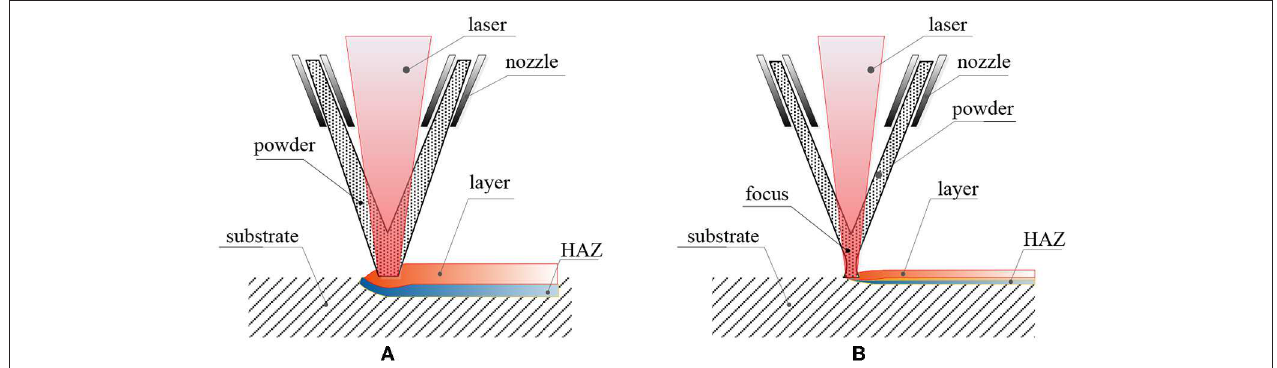
FIGURE 1 | Schematic diagram of principle of (A) LMD and (B)